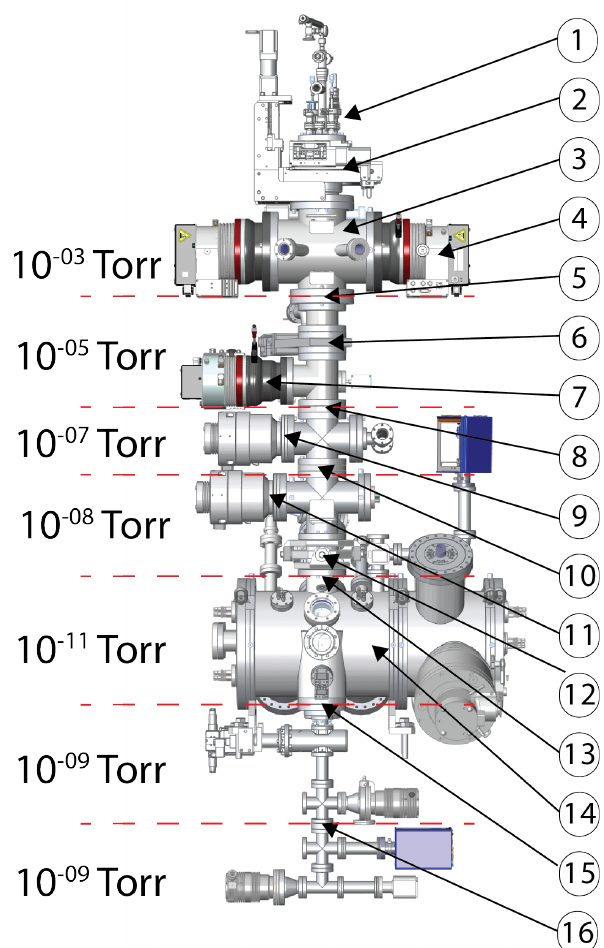
Figure 4. The DREAM gas jet and skimmer assembly; indicated on the left-hand side are the targeted pressure ranges and on the right-hand side the gas jet (1), the gas jet manipulator (2), the first skimmer chamber (3), the first skimmer pumping (4), the position of the first skimmer (5), the gate valve (6), the second skimmer pumping (7), the position of the second skimmer (8), the third skimmer chamber pumping (9), the third skimmer position (10), the fourth skimmer pumping (11), the skimmer assembly motion flexure (12), the fourth skimmer position (13), the main chamber (14), the position of the first catcher aperture (15), and the position of the second catcher aperture